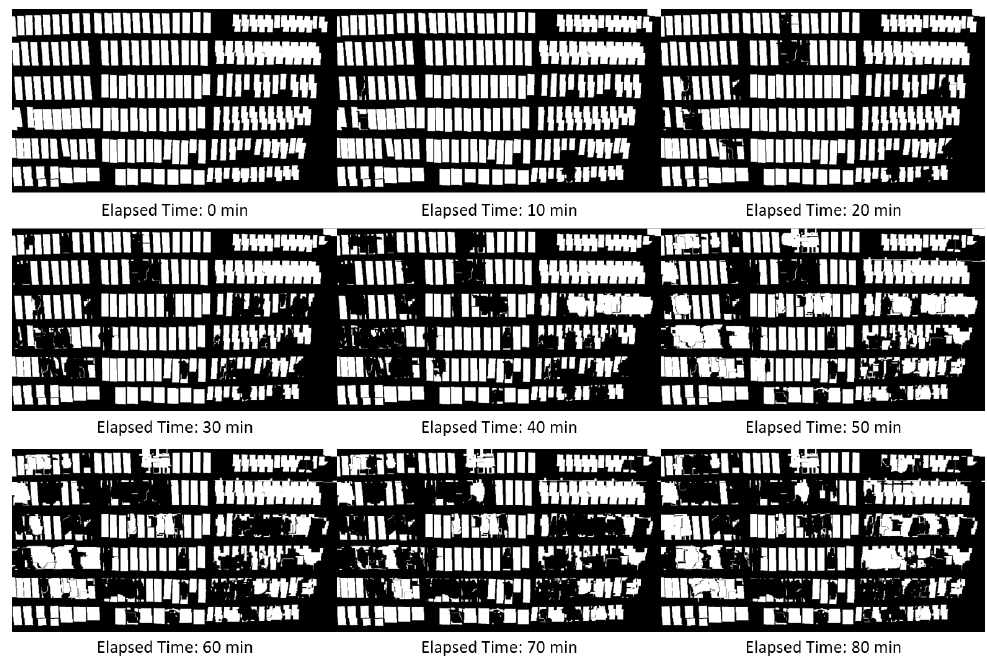
Figure 9. Examples of shelf condition updated by our